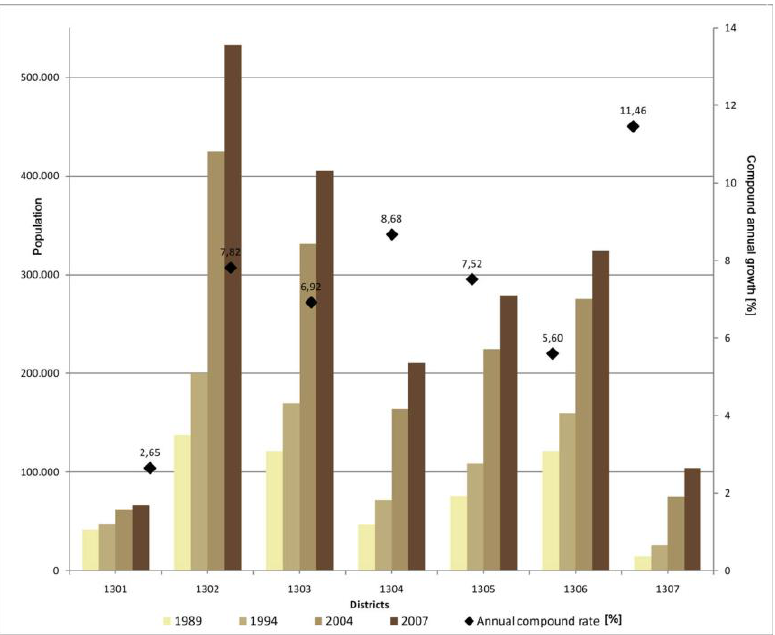
Figure 8. Population growth between 1989 and 2007 per district together with the compound annual growth